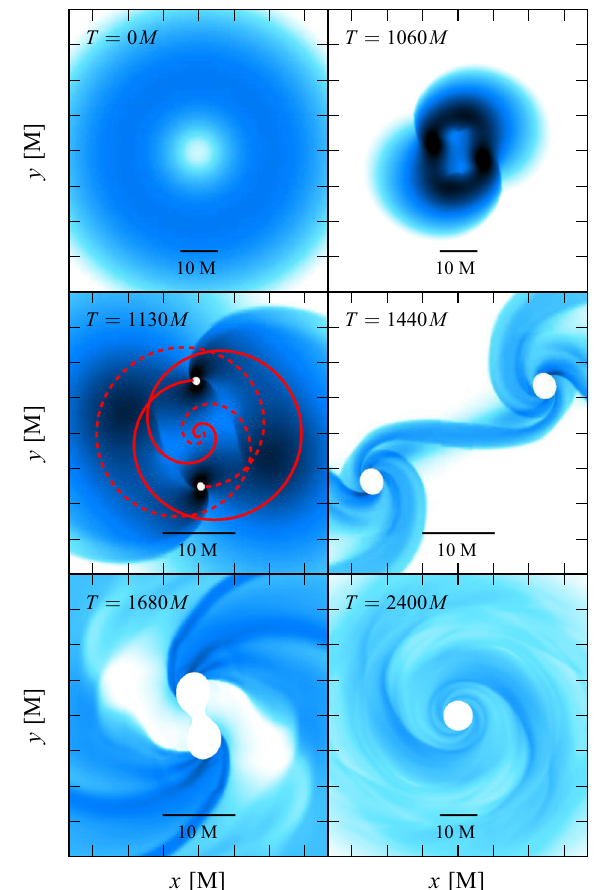
Fig. 32 Equatorial density contours at select times of a fragmenting, collapsing supermassive star, forming a supermassive black hole binary. Dark colors indicate high density, light colors indicate low density. The logarithmic density colormap ranges from 10 − 7 M − 2 (white) to 10 − 3 M − 2 (black). In the bottom two panels, the colormap is rescaled to the range [ 10 − 8 M − 2 , 10 − 4 M − 2 ] . The upper two and the bottom right panels show physical dimensions of ± 40 M , while the remaining panels show physical dimensions of ± 20 M . The white disks roughly indicate the black hole apparent horizons. (Image reproduced with permission from Reisswig et al. 2013b, copyright by